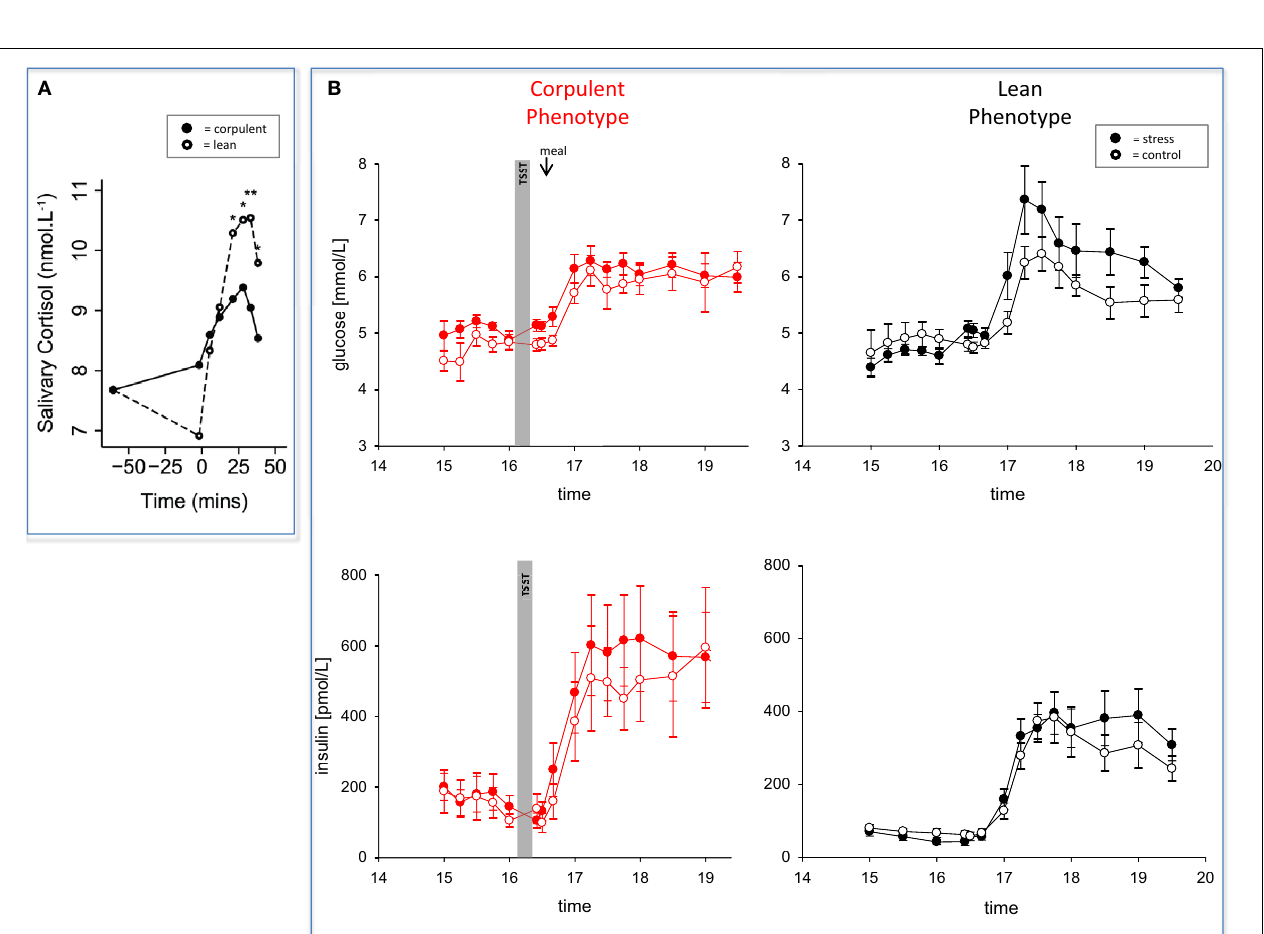
stress intervention: F = 3.8, P < 0 . 001); insulin concentrations are equal between stress and non-stress intervention (interaction time × stress intervention: F = 2.5, P > 0 . 05), by ANOVA for repeated measures. Given the increased glucose concentrations in the stress session, insulin is inadequately low, i.e. suppressed (for details see Hitze et al., 2010). Corpulent men: stress did not lead to an observable increase in glucose concentrations (interaction × stress intervention: F = 0 . 6, P = 0.554) nor in insulin concentrations in the post-stress replenishment phase (interaction time × stress intervention: F = 0.4, P = 0.771) (Kubera et al.,